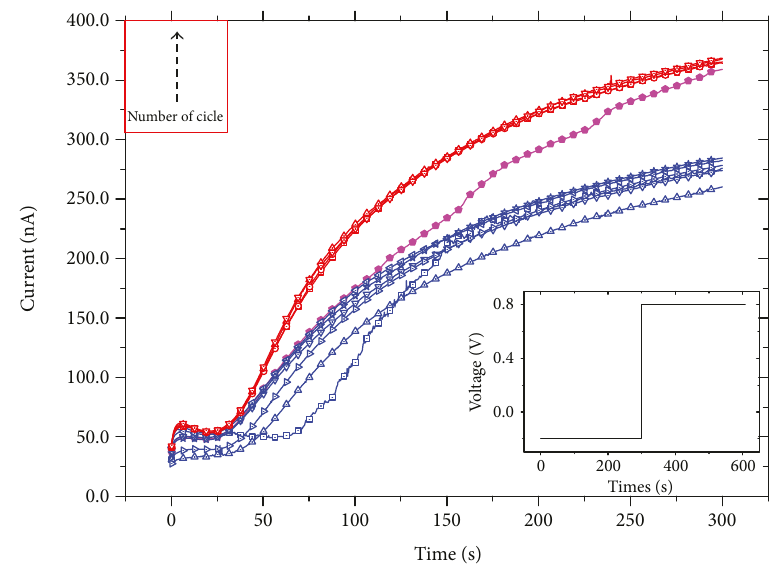
Figure 1: Demonstration of the LTP mechanism in the organic memristive devices: the blue curves are the initial responses, red ones are the fi nal, and magenta is the transition curve. The pro fi le of the given pulse is shown in the